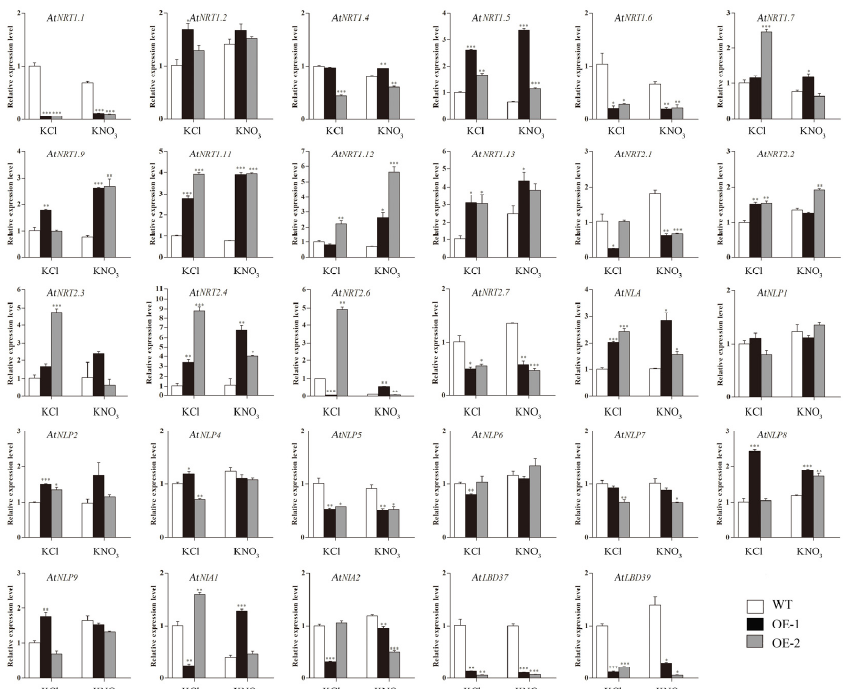
Figure 13. The expression levels of nitrate response related genes in leaves of WT and transgenic Arabidopsis plants hosting CsLBD39 gene under KCl and KNO 3 conditions. The data are expressed as mean ± standard deviation of three biological replicates ( n = 3). Asterisks (*) indicate that the value is significant difference compared to the WT (* p < 0.05; ** p < 0.01; *** p < 0.001).